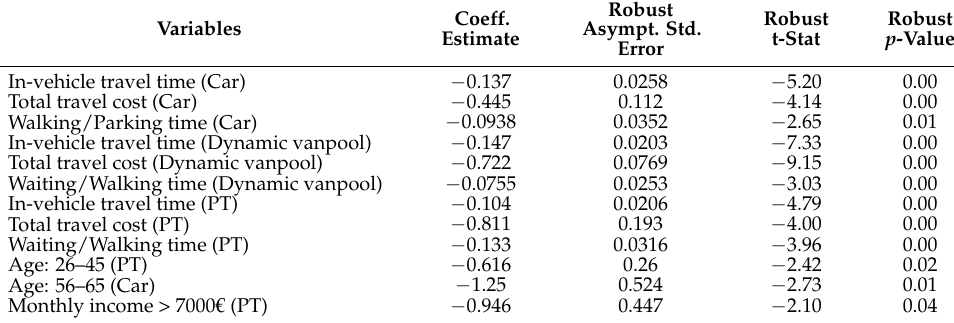
Table 4. MNL estimation